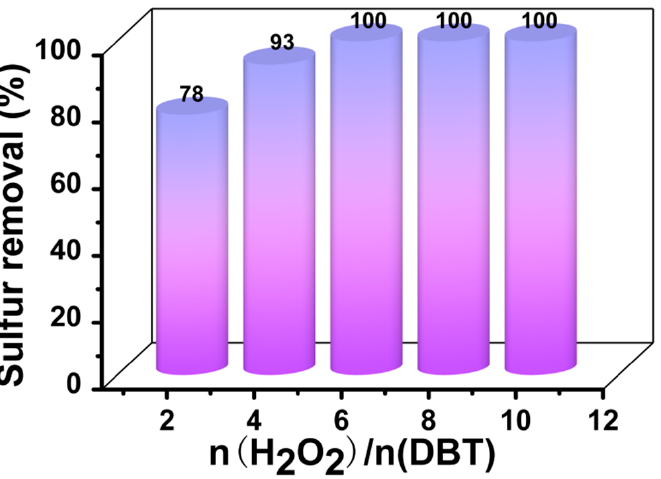
Figure 9. Effect of O/S ratio on sulfur removal efficiency of DBT Experimental conditions: T = 60 ◦ C, V DBT = 5 mL, V IL = 3 mL, m([BMIM] 3 PMo 12 O 40- based MCF) = 30 mg, and t = 1.5 h.